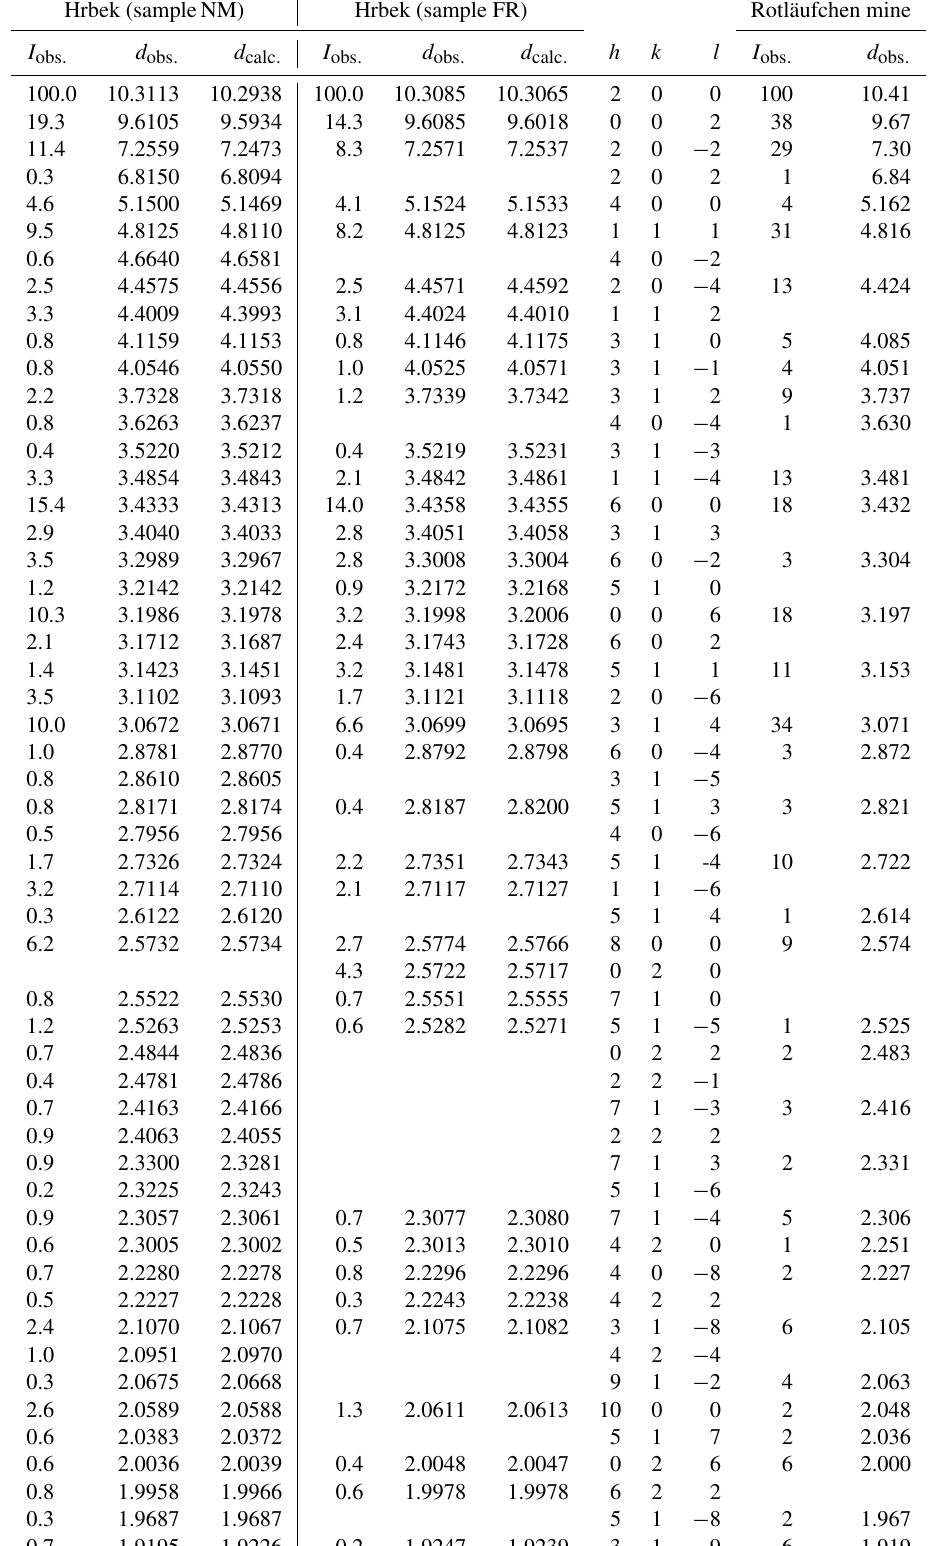
Table 3. X-ray powder patterns of beraunite from Hrbek (samplesNM and FR) compared with data for eleonorite from the Rotläufchen mine. Hrbek (sampleNM) Hrbek (sample FR) Rotläufchen mine I obs